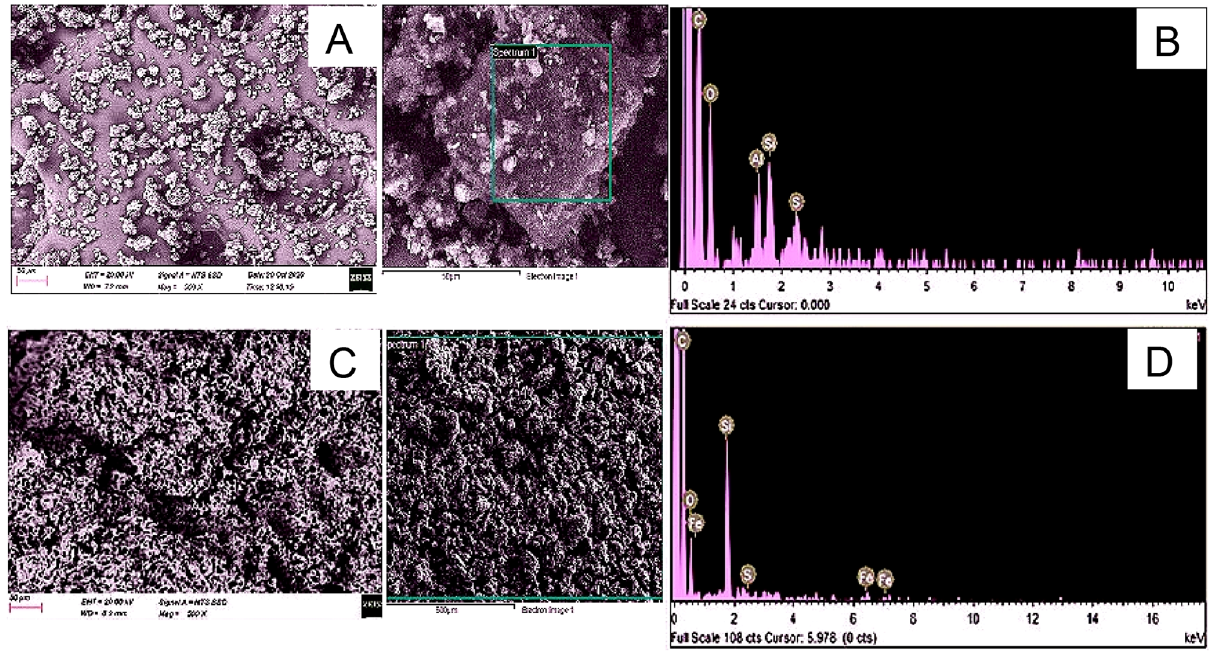
Figure 12. SEM images ( A , C ) and EDX elemental spectrums ( B , D ) of coal slurry (up), and coal slurry’s hydrochar (down).